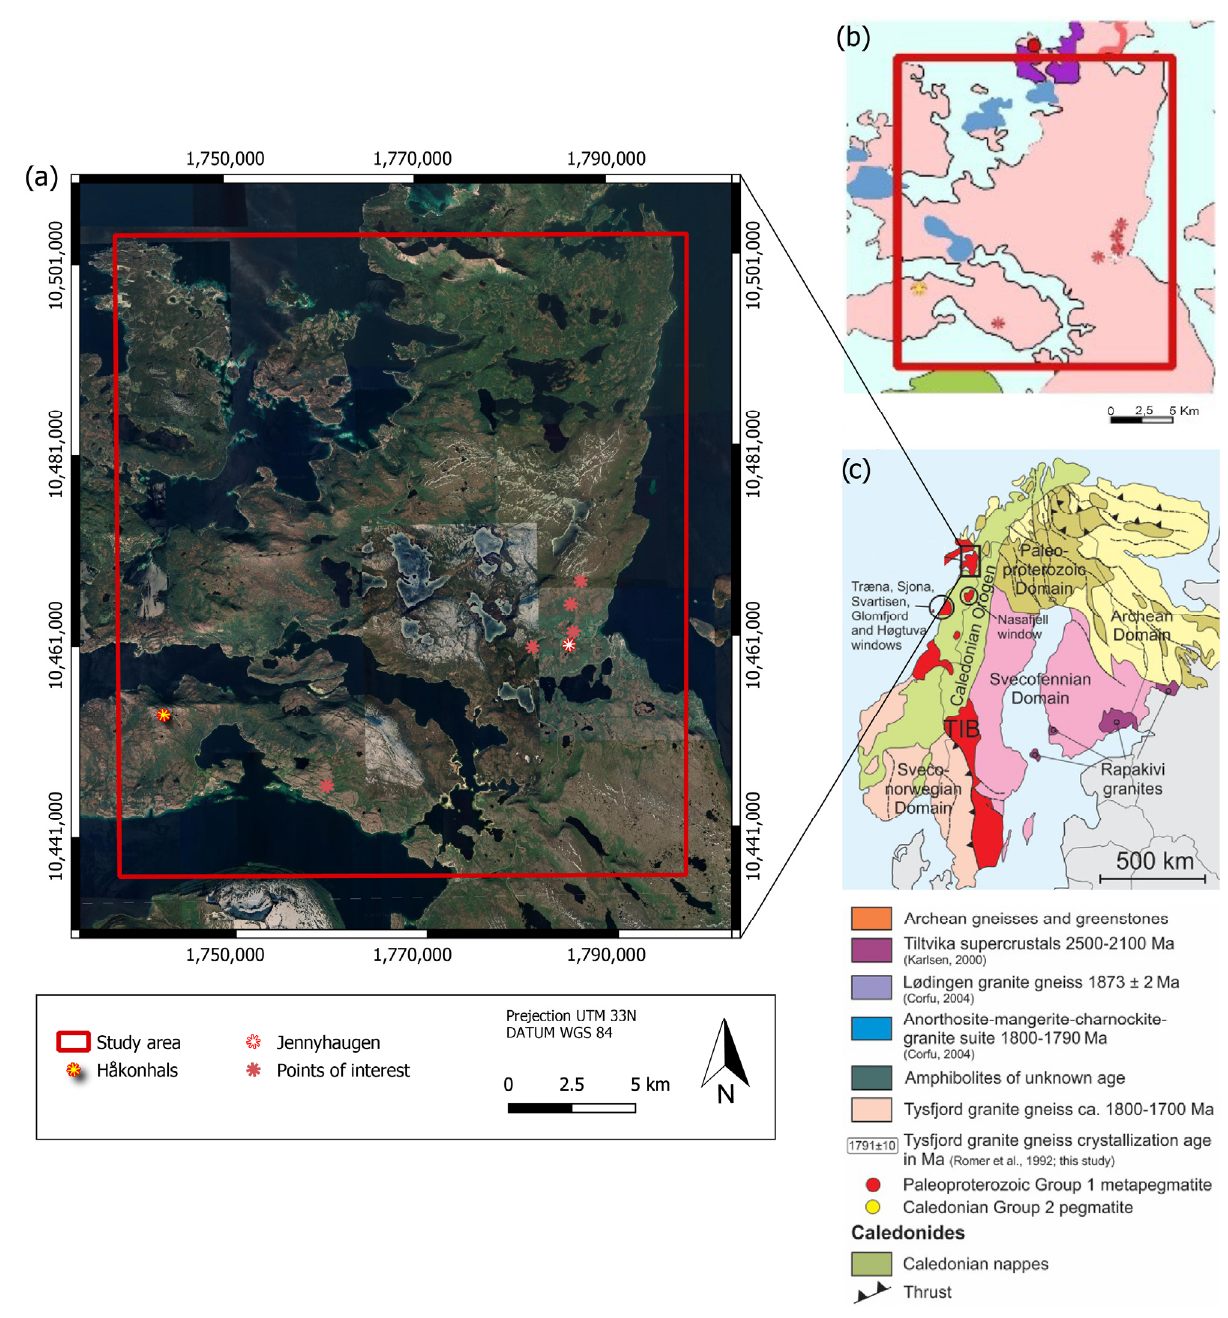
Figure 1. Location of the study area. ( a ) Overview image of the Tysfjord district where the study area is framed by the red square. The Håkonhals pegmatite is marked with a yellow star, Jennyhaugen mine with a white star, and other pegmatites with red stars. ( b ) Simplified geologic map. ( c ) Detailed geological map and location of the study area in Norway. TIB: Trans-Scandinavian Igneous Belt. Adapted with permission from Müller et al. [4,5].